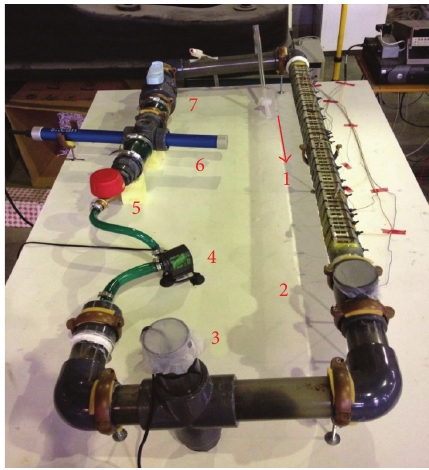
Figure 1: MFC prototype used in laboratory: (1) active section of the plant, where electrodes are situated; (2) sampling port; (3) discharge tap,equippedwiththermostat;(4)recyclepump;(5)volumetricflow meter; (6) spectrophotometric probe; (7) ball valve for flux tuning.